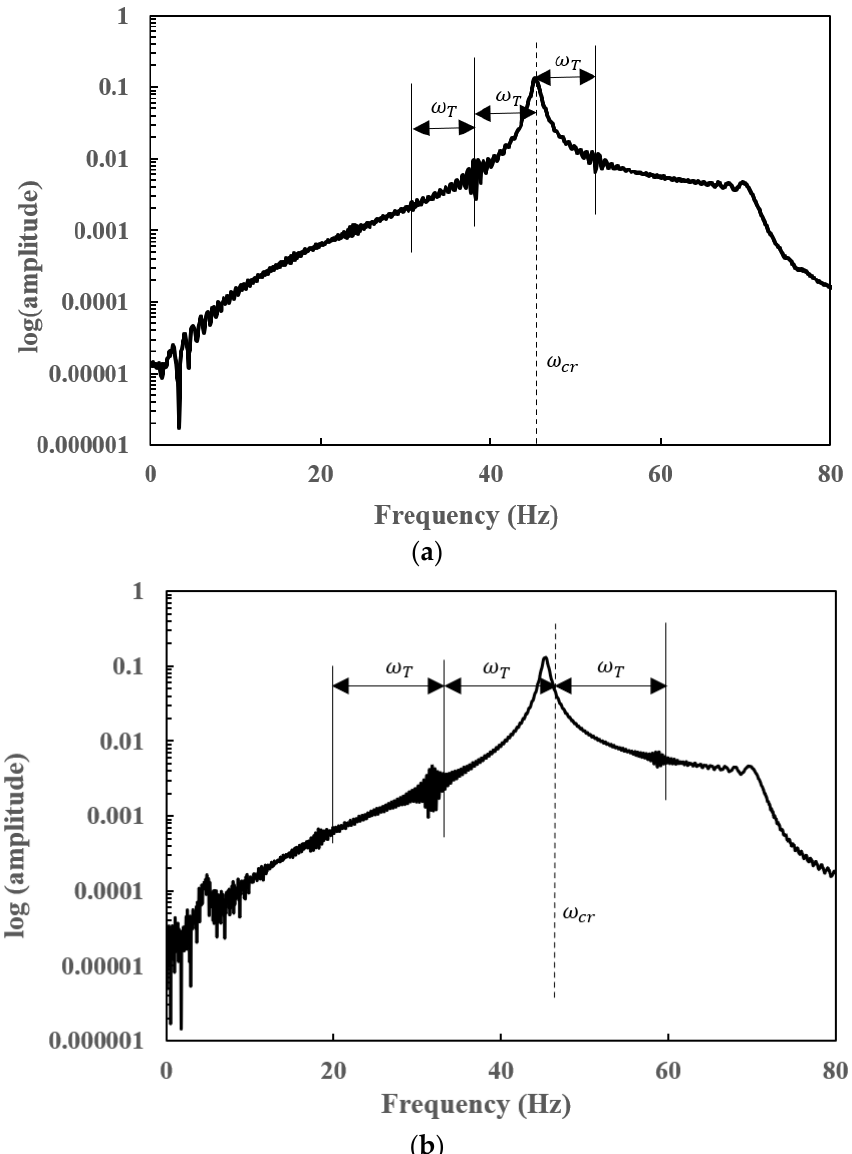
Figure 16. Transient FFT of a slant − cracked EG rotor-bearing system with an angular acceleration of 30 rad/s 2 with α = 0.3 for torsional frequency ( a ) ω T = 45 rad/s ( b ) ω T = 85 rad/s. The presence of a crack can be detected even when the EG shaft is subjected to temperature gradients. Transient frequency spectra of an uncracked and cracked EG rotor- bearing system have been represented in Figure 17a,b for different thermal gradients. The amplitude of the frequency spectra at ∆ T = 300 K is higher than the amplitude at ∆ T = 0. As the first critical speeds of the uncracked and cracked EG rotor-bearing system at ∆ T = 0 and ∆ T = 300 K are different, the split between the first peaks is observed in Figure 17a,b. The subharmonic peaks are visible in the frequency responses when the crack is present.